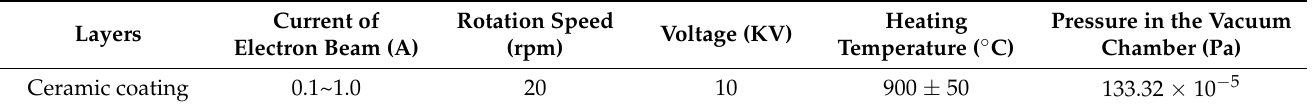
Table 3. Preparation parameters of EB-PVD for 8YSZ ceramic